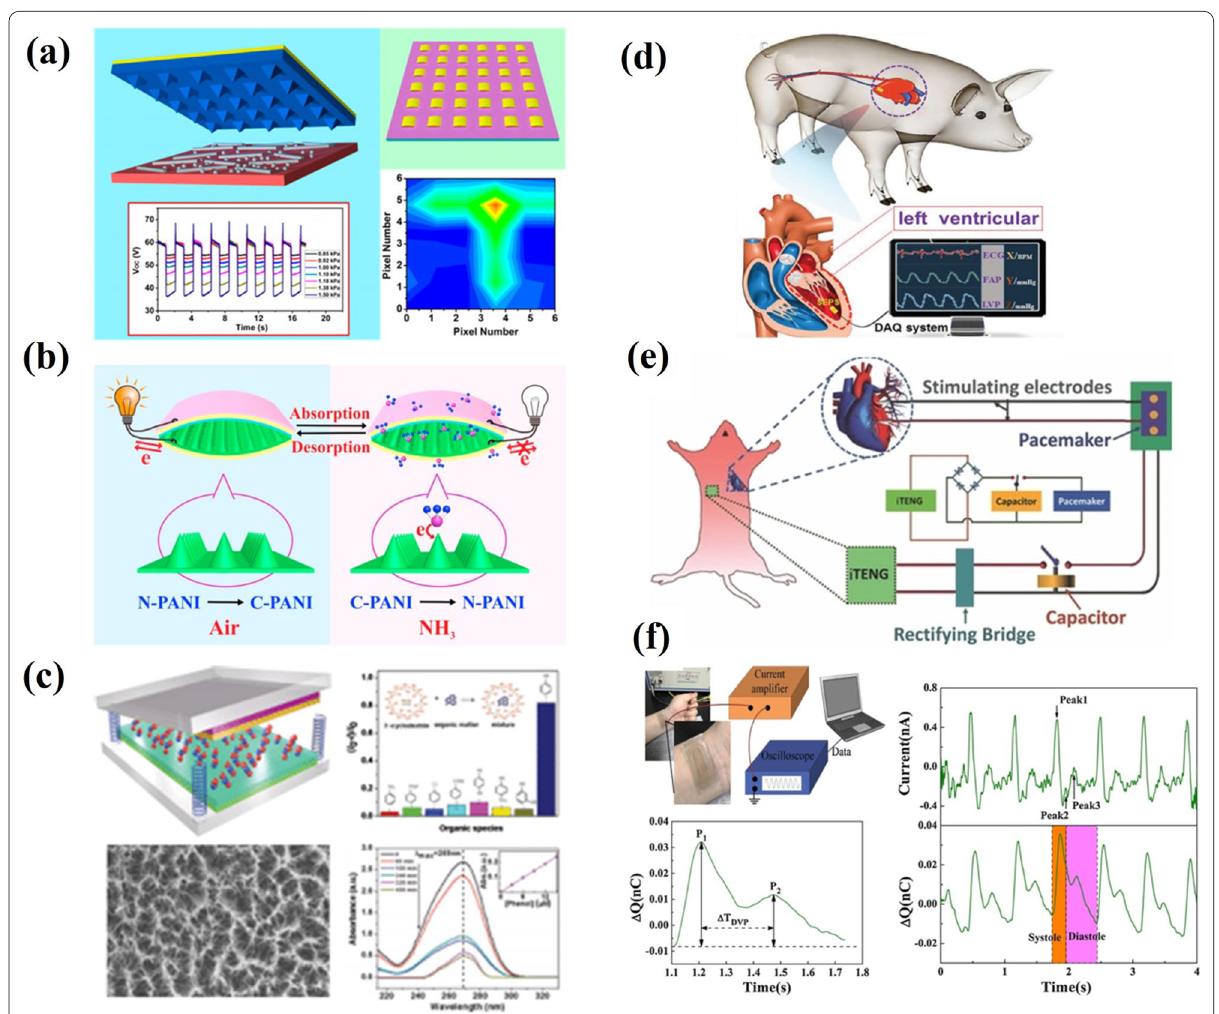
Fig. 18 Different applications of TENG: a a sensor array for self-powered static and dynamic pressure detection and tactile imaging (Reproduced with permission from Ref. [118]); b a self-powered ammonia nanosensor developed from conducting polyaniline nanofibers (Reproduced with permission from Ref. [119]); c self-powered detection sensor and electrochemical degradation of phenol utilizing β-cyclodextrin enhanced triboelectrification (Reproduced with permission from Ref. [120]); d a self-powered endocardial pressure sensor implanted into a swine’s heart (Reproduced with permission from Ref. [121]); e a diagram of an in vivo self-powered prototype of a pacemaker from the breath of a living rat (Reproduced with permission from Ref. [122]); f a pulse sensor based on SETENG (Reproduced with permission from Ref.